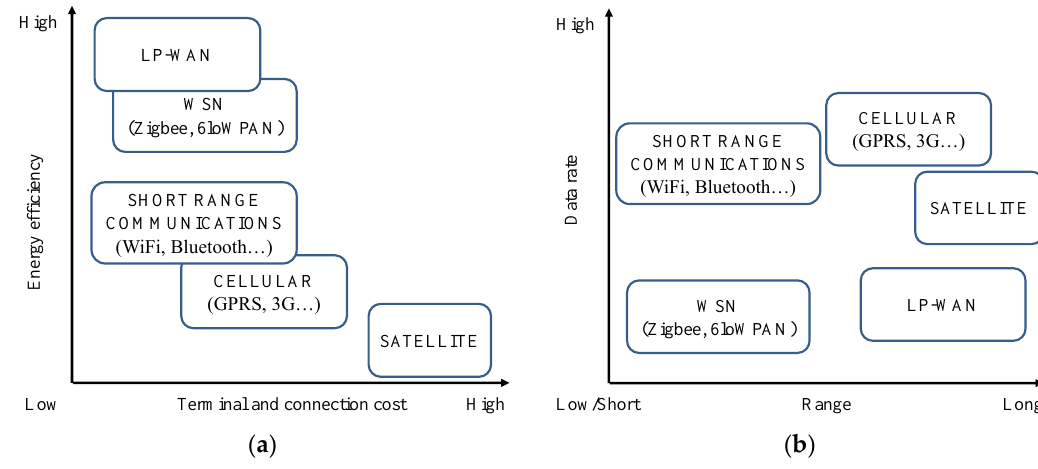
Figure 3. Principal characteristics of IIoT-enabling technologies. ( a ) Data rate and coverage range; ( b ) Energy efficiency and terminal and connection cost.